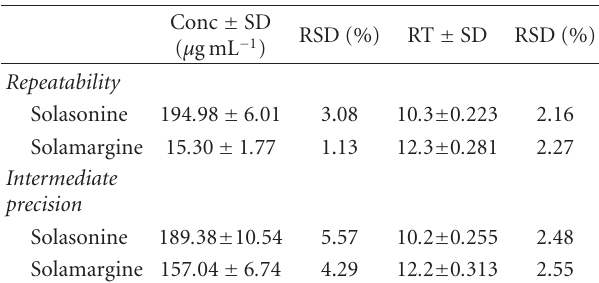
Table 3: Repeatability and intermediate